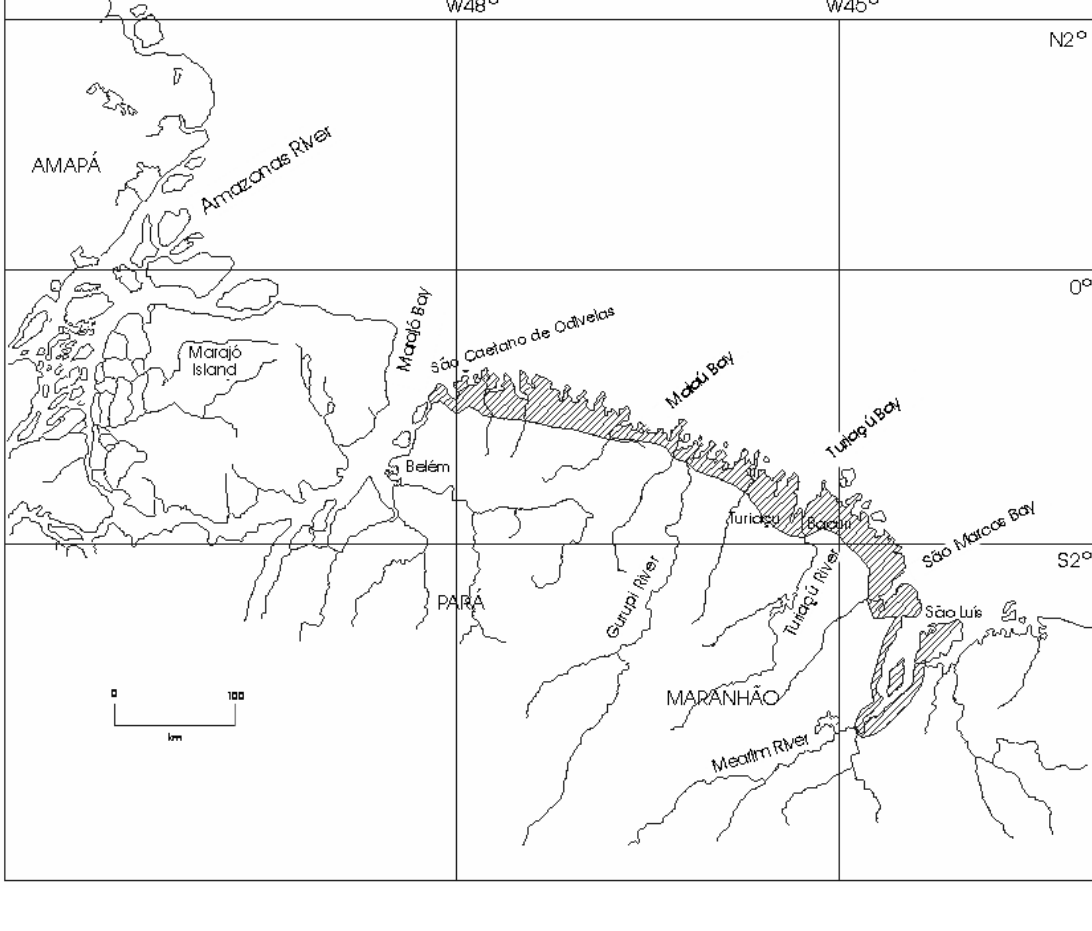
Fig. 1 – Localization of the Turiaçú